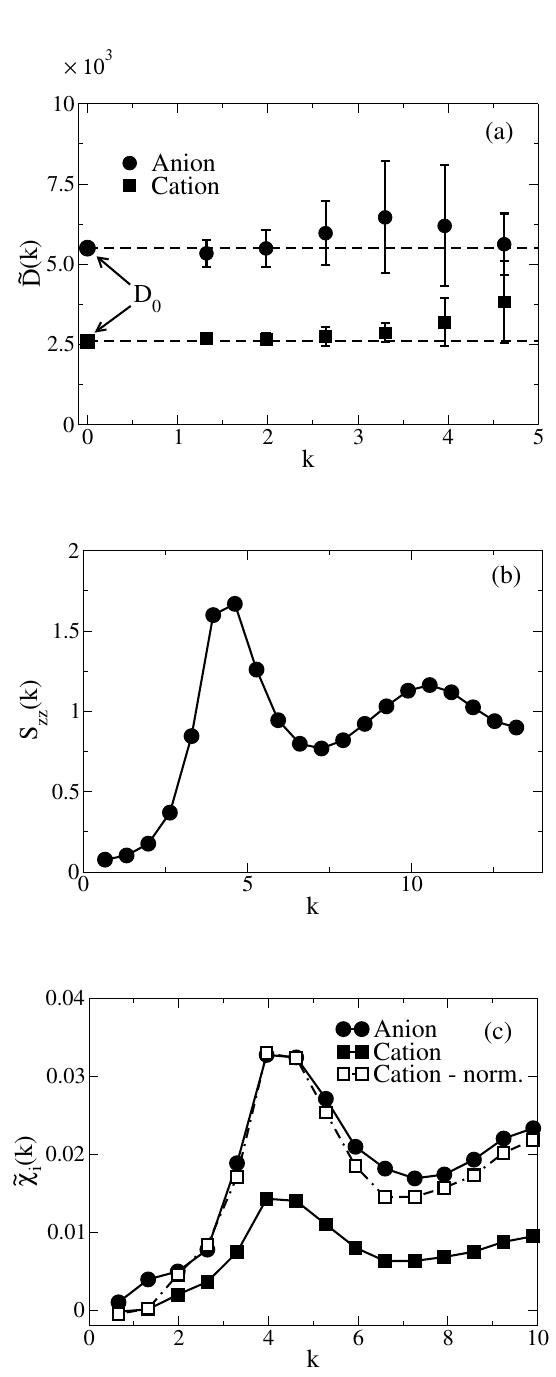
Figure 5: Ionic liquid. (a) Diffusion kernels for the anion and cation. (b) Charge-charge structure. (c) wavevector dependent response function connected with punctured line is the normalized cation response function. For all figures lines serve as a guide to the